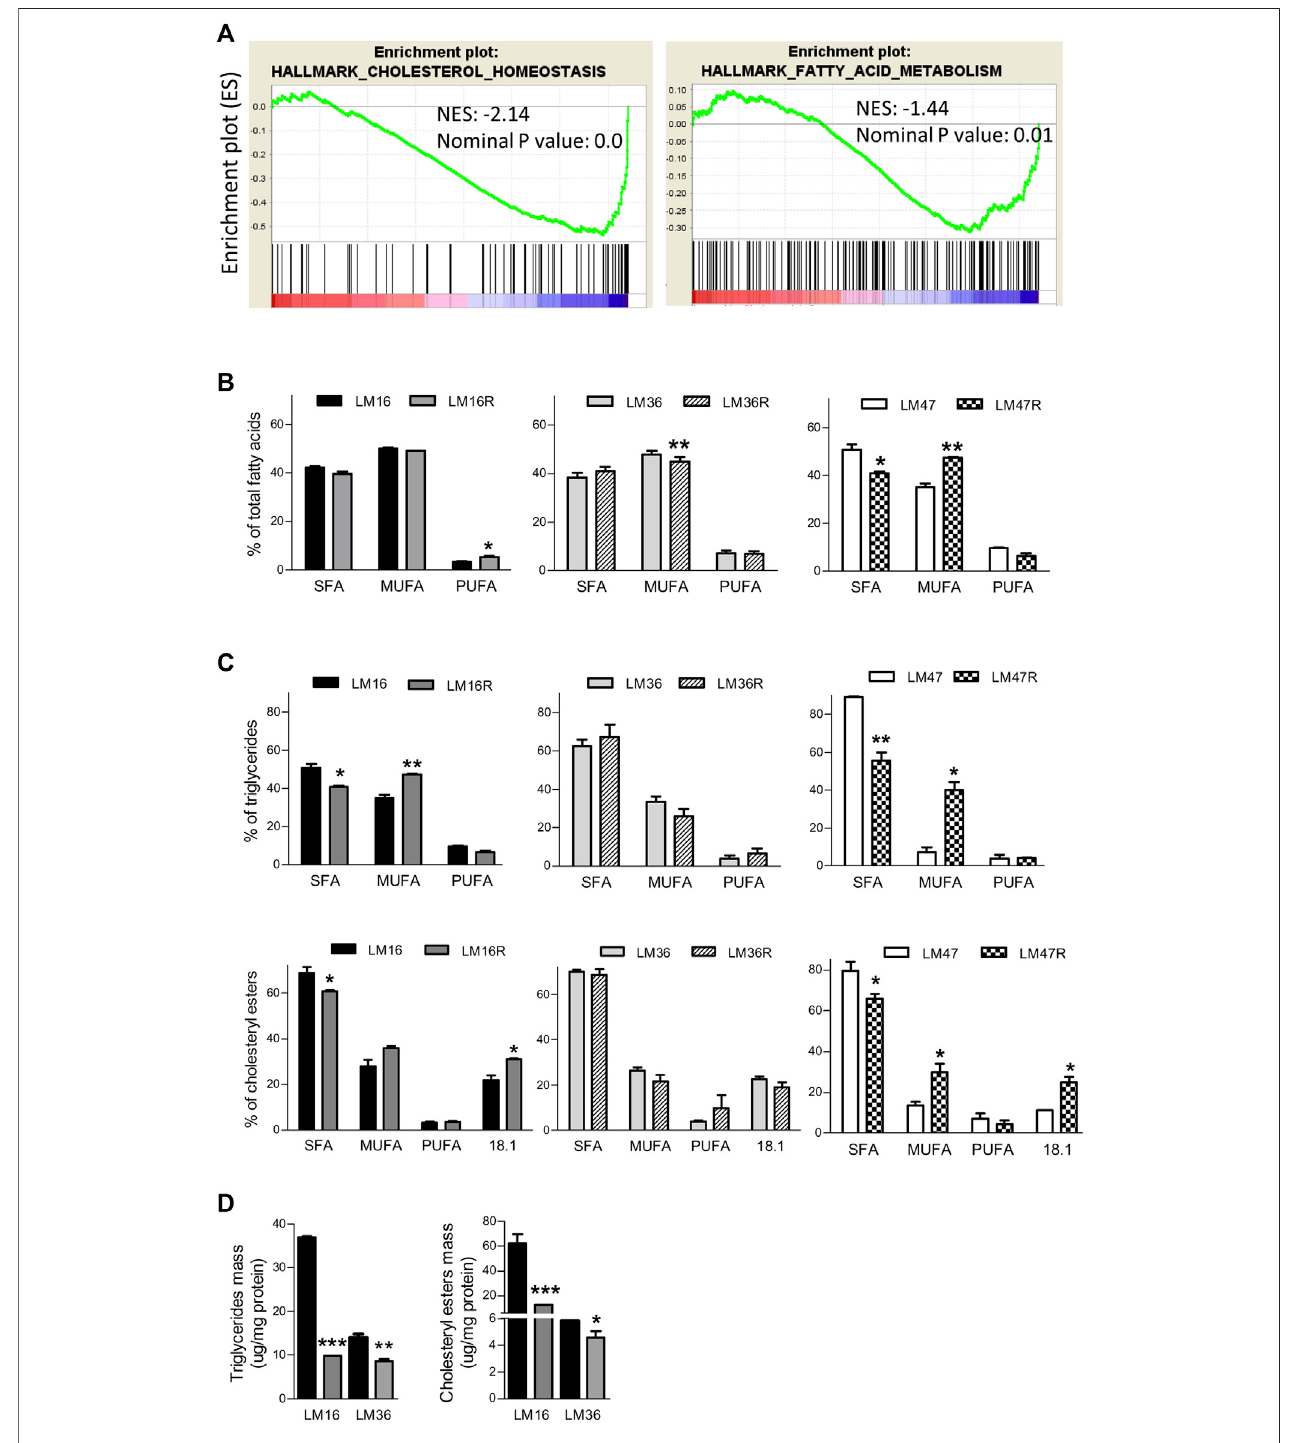
FIGURE 1 | Lipid metabolism alterations in BRAFi-resistant melanoma cell lines. (A) . GSEA enrichment plots of lipid metabolism-related gene sets that are downregulatedintheBRAFi-resistantcellswhencompared totheparentalcelllines.NESandnominal p valueareshown. (B) .Graphreports relativepercentage ofSFA, MUFAand PUFAintotalFAdetected byGLCinLM16/LM16R, LM47/LM47Rand LM36/LM36R celllinepairs. (C) .percentagesofSFA,MUFAand PUFAcontentinTG and CE. (D) . Quanti fi cation of TG and CE mass. * p < 0.05, ** p < 0.01 and *** p < 0.0001 by unpaired Student ’ s t test.